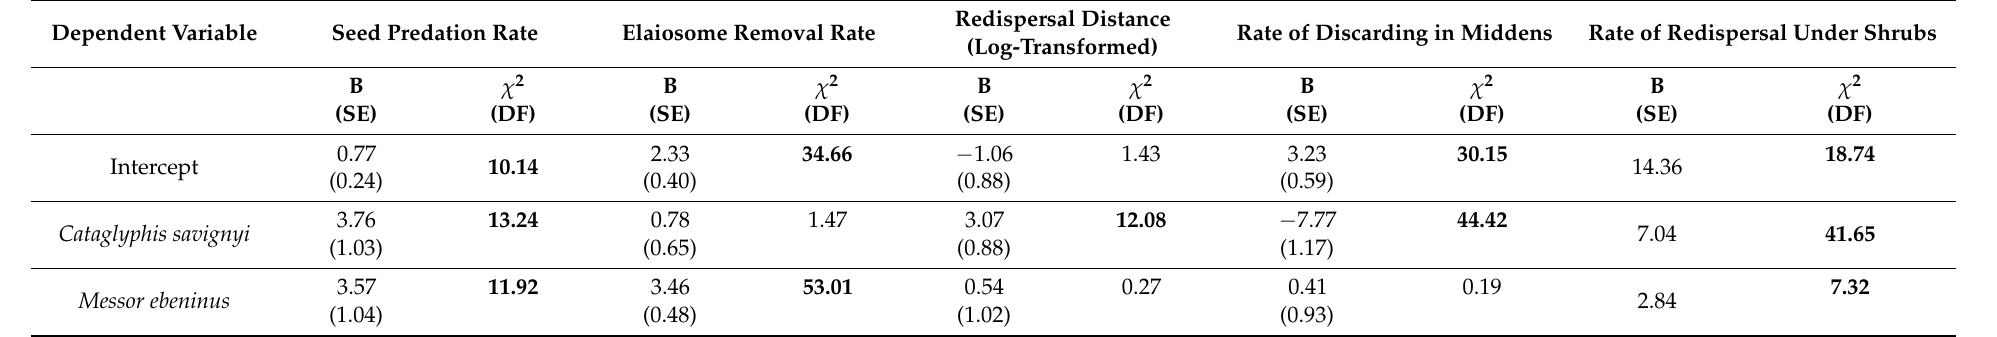
Table A3. Summary of the GLMs testing the effect of each ant species on variables of seed fate and final location—coefficient values (marked by Bs) are calculated relative to Messor arenarius (which is included in the intercept); significant effects are in bold. All the χ 2 tests that appear in the table has a df =